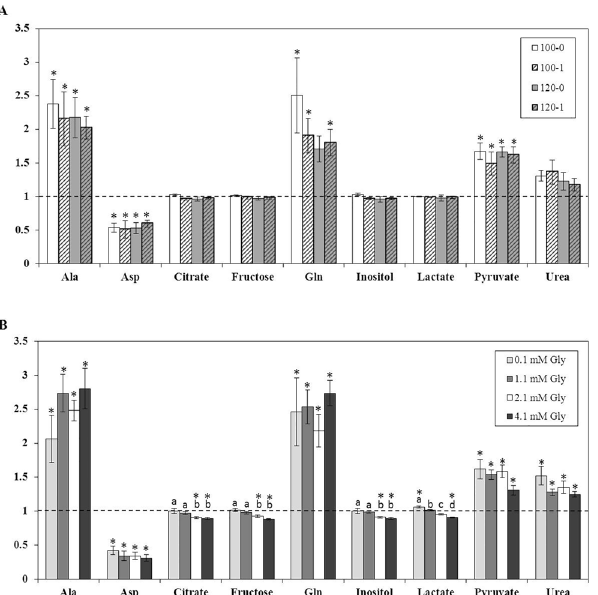
Fig 3. Relative change in the composition of culture media following a 48 h incubation with embryos while they developed from the morula to hatching blastocyst stage in experiment 1 (A) or 2 (B). The amount of each nutrient present in the medium at the end of the incubation is expressed as the fold change in abundance compared to control media that did not contain an embryo (dashed line). An asterisk ( * ) indicates a significant (P < 0.05) change compared to control media. Different letters ( a,b,c,d ) indicate a significant (P < 0.05) difference in the amount of each nutrient between treatments. If no asterisk or letters are present, there were no differences (P >